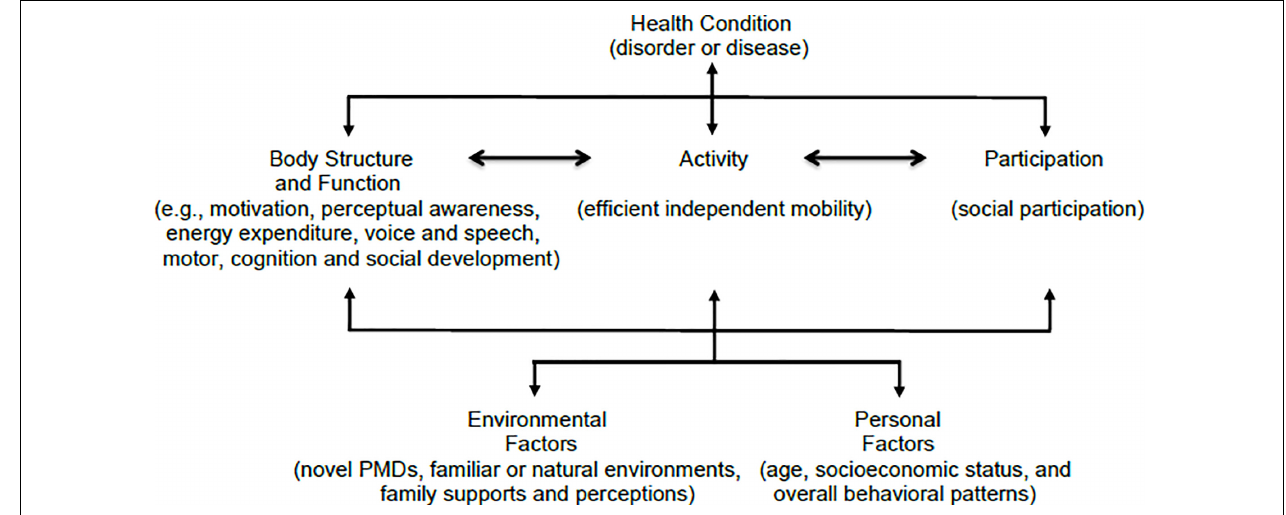
FIGURE 1 | The World Health Organization international classification of functioning, disability, and health (2001).